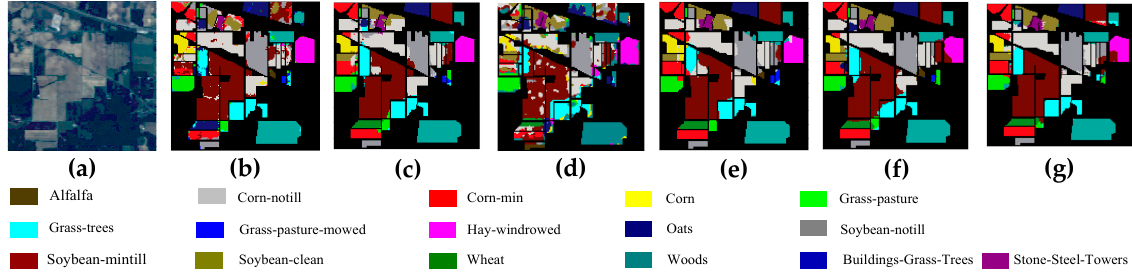
Figure 15. Indian Pines. ( a ) False-color composite image. The classification maps using ( b ) EMP-SVM; ( c ) CNN; ( d ) SSRN; ( e ) VGG; ( f ) SST-FA; ( g ) T-SST-L.